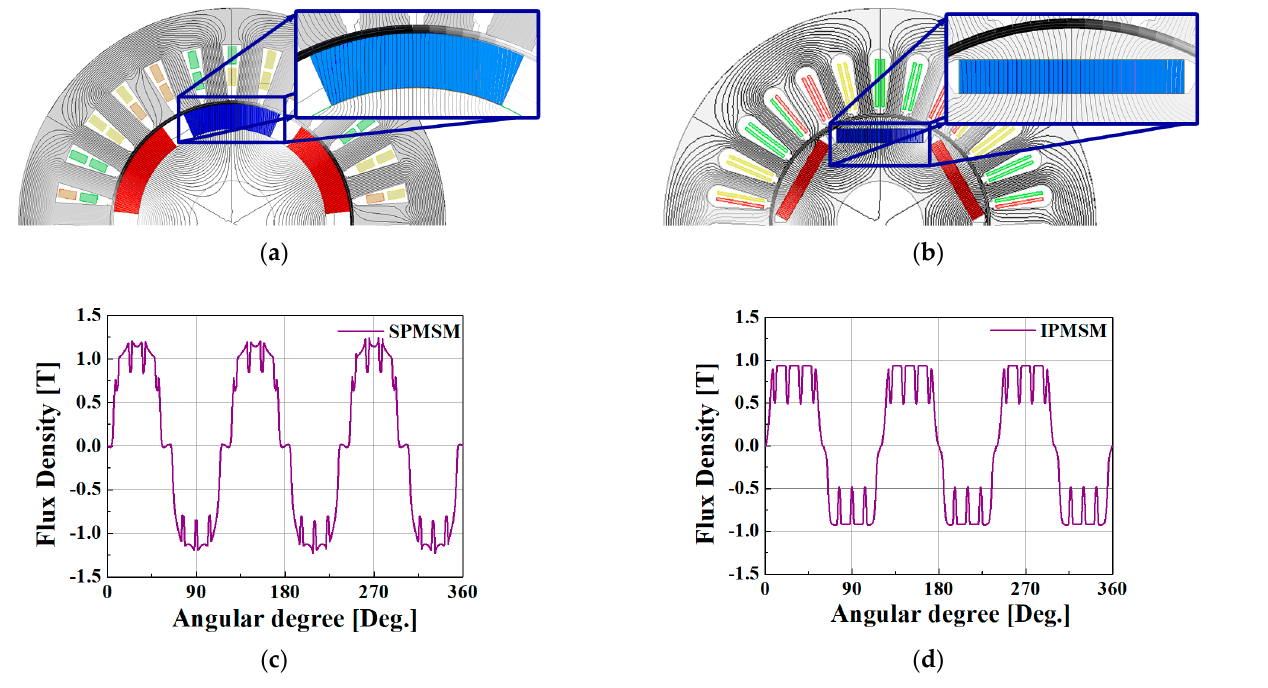
Figure 7. Flux density analysis results: ( a ) flux lines of SPMSM; ( b ) flux lines of IPMSM; ( c ) flux density of SPMSM ( d ) flux density of IPMSM .